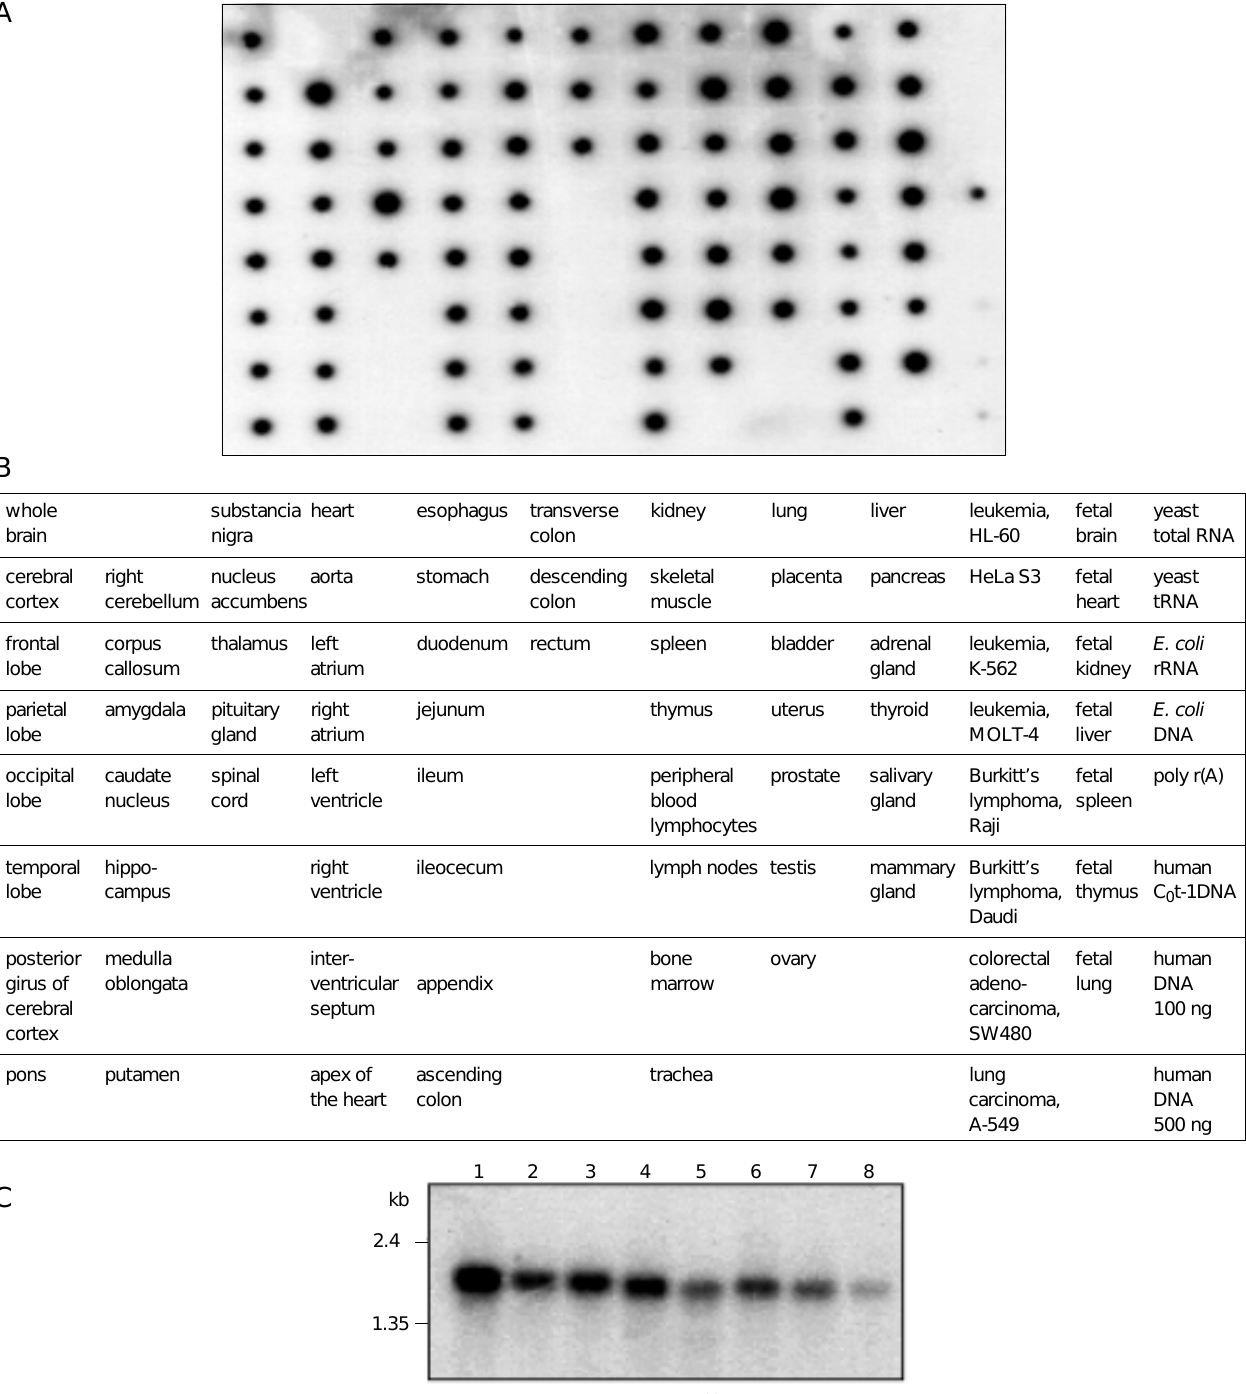
Figure 3. The expression pattern of DDX26 in normal tissues and tumor cell lines. A 32 P-labeled probe was hybridized under stringent conditions to a Human Master Blot (Clontech) containing normalized loadings of polyA + RNA from 75 different human tissues (A) as well as to a Cancer Cell Lines Northern blot (Clontech) containing 2 µg of polyA + RNA (C). B , Location of the various RNAs on the dot blot filter is shown schematically. C , For the Northern blot membrane, the cancer cell lines are: 1 , melanoma, G-361; 2 , lung carcinoma, A-549; 3 , colorectal adenocarcinoma, SW480; 4 , Burkitt’s lymphoma, Raji; 5 , lymphoblastic leukemia, MOLT-4; 6 , chronic myelogenous leukemia, K-562; 7 , HeLa S3, and 8 , promyelocytic leukemia, HL-60. Molecular markers (kb) are